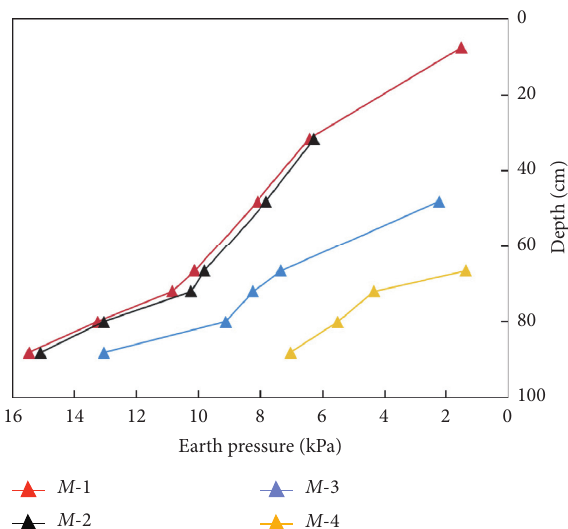
Figure 18: Earth pressure in front of the wall of 0.36H.